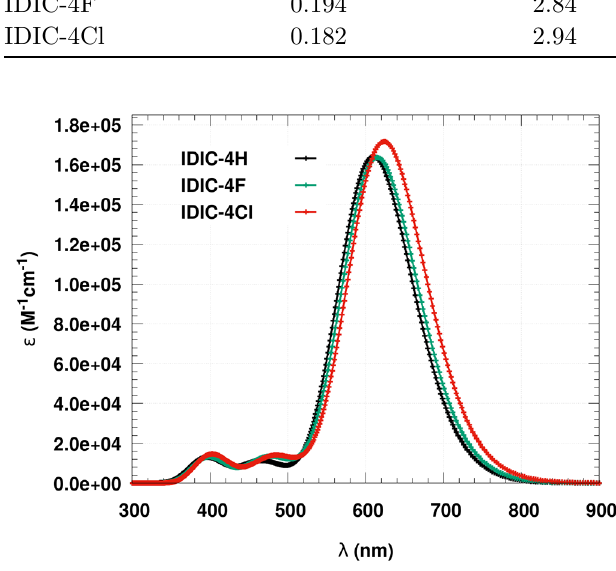
Fig. 5. Absorption spectra for the three